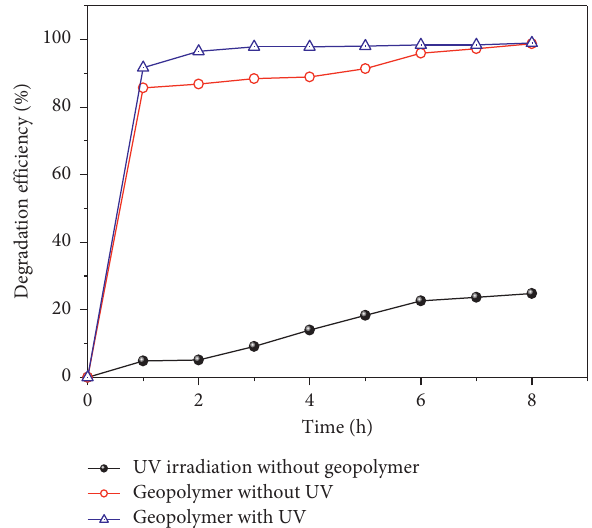
Figure 6: Photocatalytic degradation efficiencies of MB dye at different